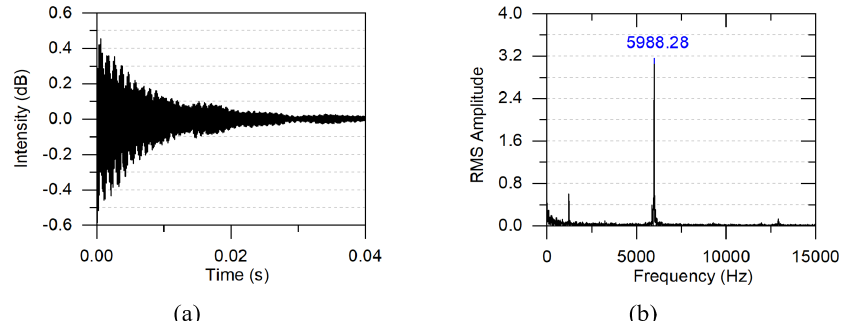
Figure 14. Microphone signal in (a) time and (b) frequency